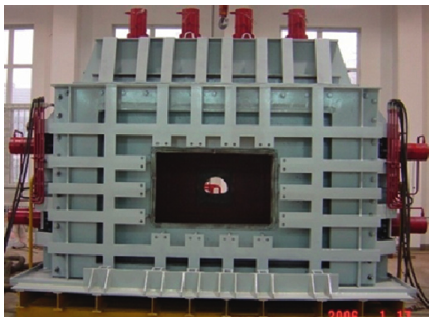
Figure 12: Front view of the test rack.